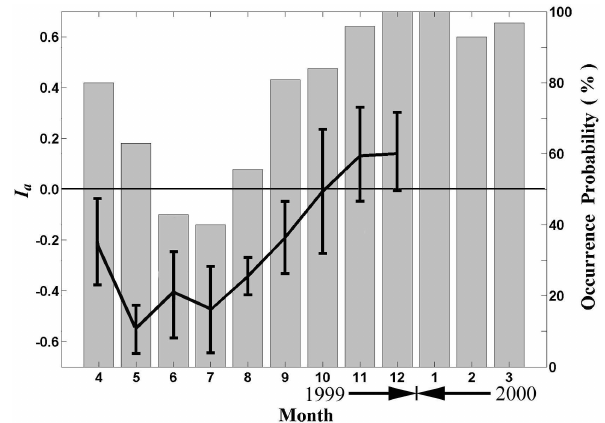
Fig. 6. Seasonal variation in the monthly mean value of I a (soild line) and the associated standard deviation (error bar) during April 1999-March 2000. The gray histogram in the background repre- sents the occurrence probability of ESF. Notice that I a is not esti- mated during December 1999–March 2000, because the GPS data of BOGT are not available in these